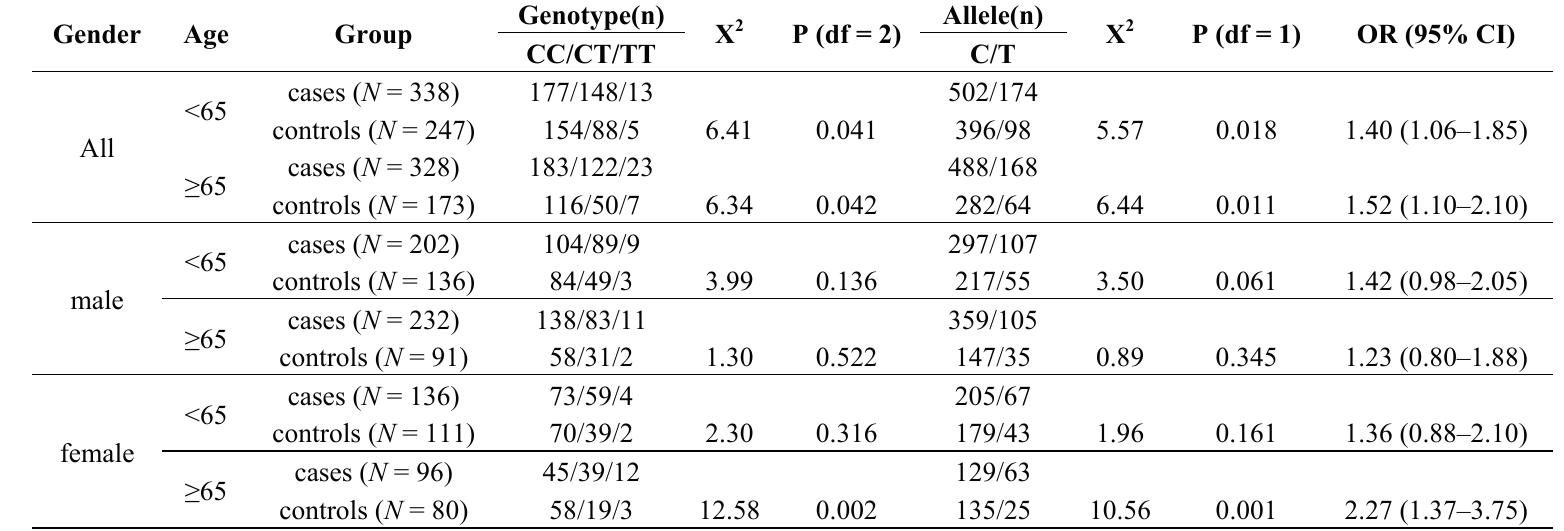
Table 4. Post hoc analysis of ACP1 rs3828329 with the risk of CAD in different age